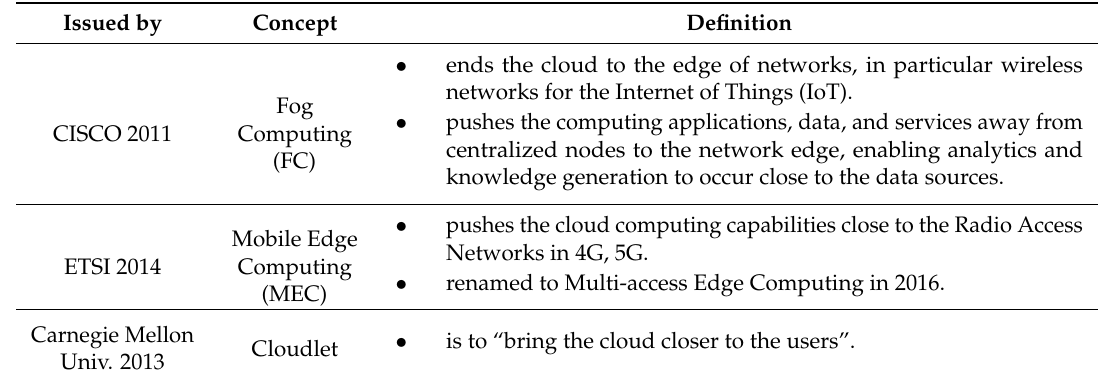
Table 1. A summary of edge-related